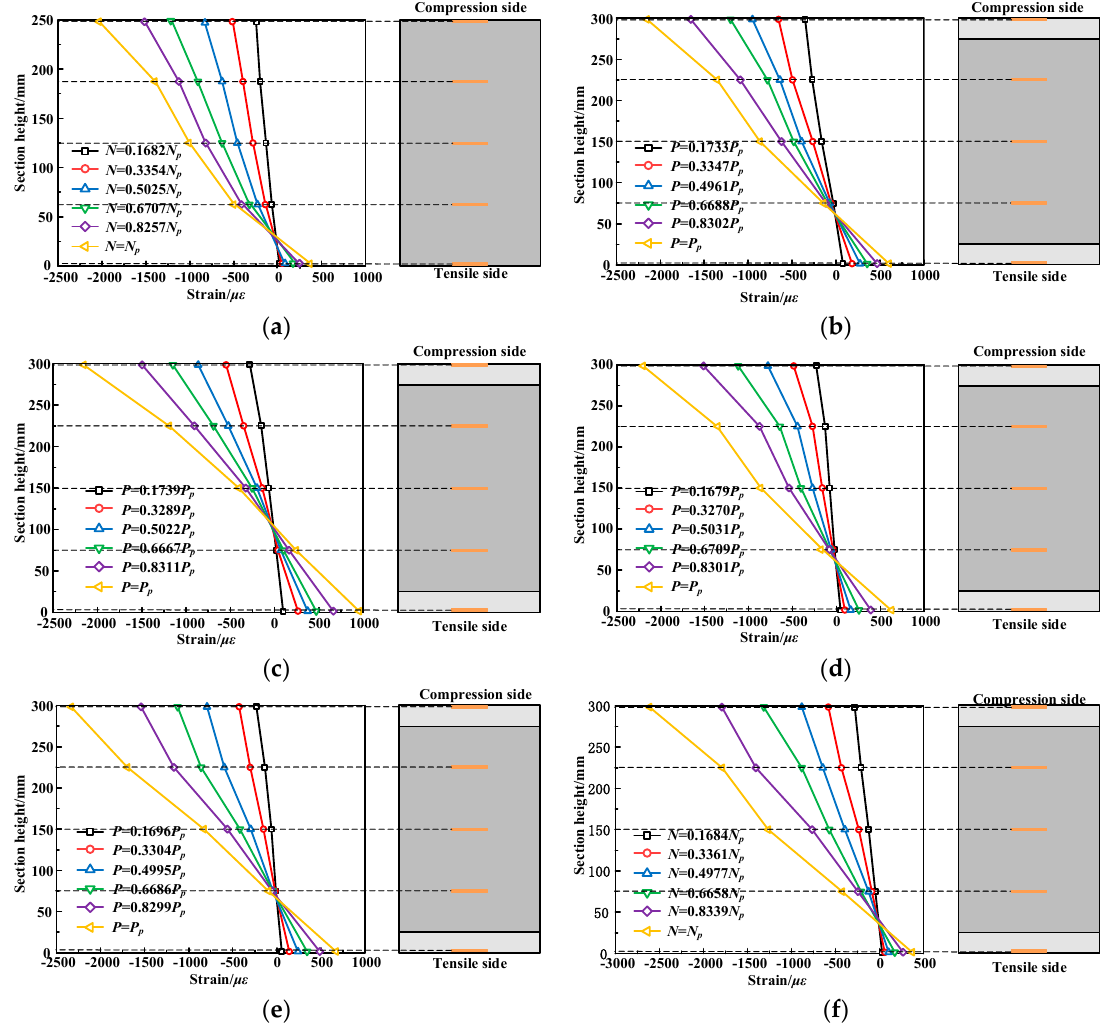
Figure 17. Strain distribution in the mid-span section. ( a ) ORC; ( b ) SCE-0.22; ( c ) SCH3-0.27; ( d ) SCH3-0.22; ( e ) SCH5-0.22; ( f ) SCH3-0.15.